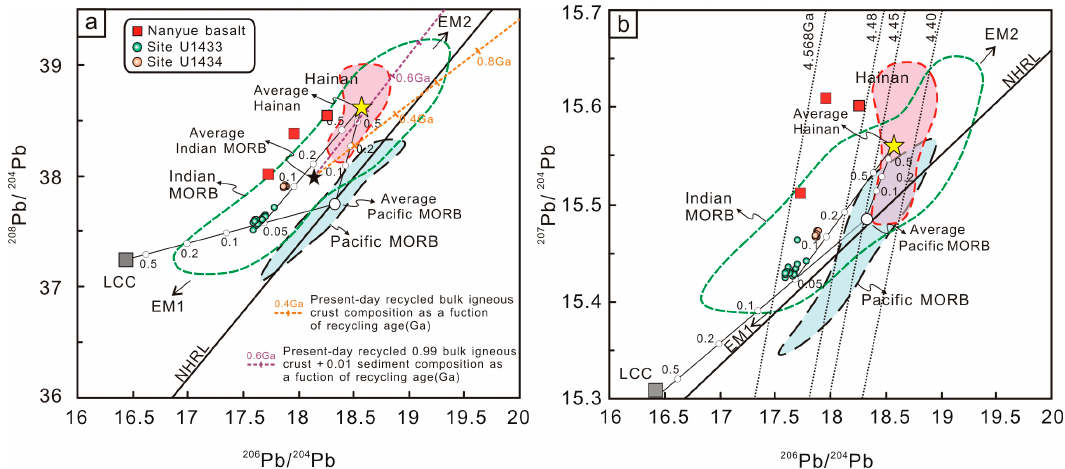
Figure 6. Isotopic plots of: ( a ) 208 Pb/ 204 Pb vs. 206 Pb/ 204 Pb and ( b ) 207 Pb/ 204 Pb vs. 206 Pb/ 204 Pb for the Nanyue basalts. Sources of data for comparison: the Pacific MORB and the Indian MORB are from [30] and the Hainan OIB is from [11,12,28,31]. The Northern Hemisphere reference line (NHRL) is from [37]. Sources of data used for the end-member mixing calculations: the average isotopic composition of the Hainan OIB is from [11,12,28,31], the average isotopic composition of the Pacific MORB is from [30], and the isotopic composition of the LCC is from [35]. Each white dot on the mixing lines represents various increments of melt fractions from the average Hainan OIB, the average Pacific MORB, and the LCC. Data references of enriched mantle (EM)-I and -II end-members are from [36]. The geochrones in (a) are from Figure 3(a) in [13]. Compositional data of volcanic rocks from the IODP Sites U1433 and U1434 are from [5].